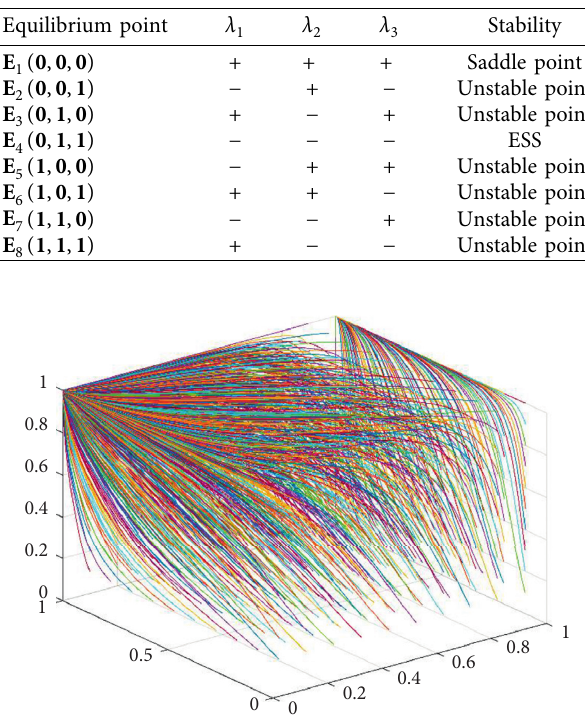
Figure 1: Evolution path of tripartite game behavior with different initial